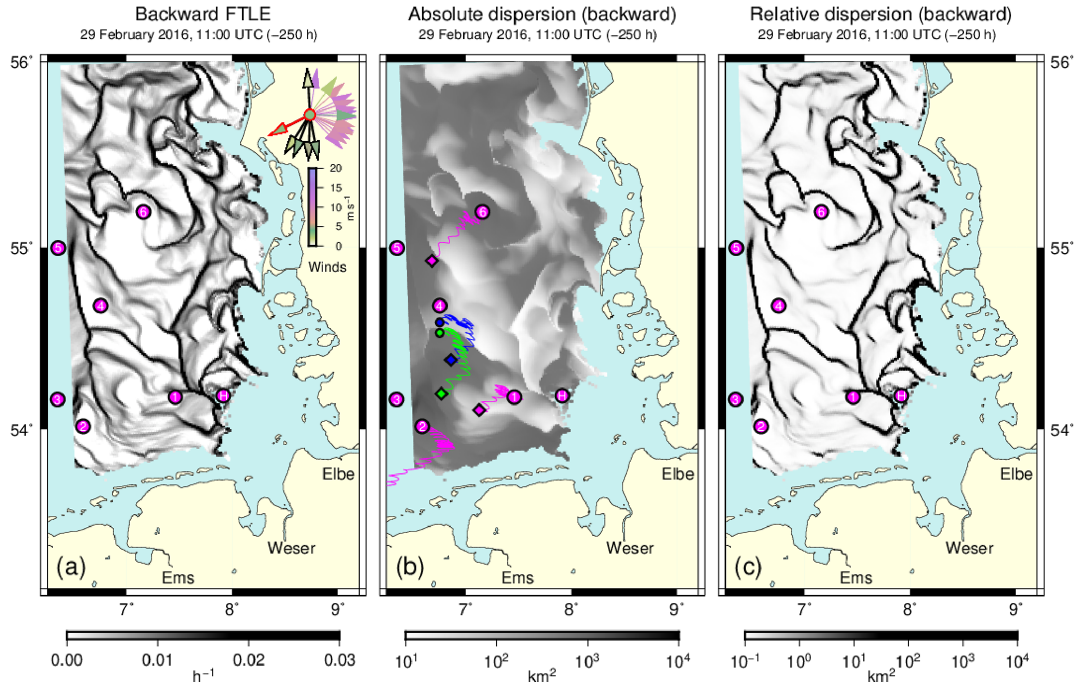
Figure 4. (a) Backward FTLE field (integration time 250h) for 29 February 2016 (11:00UTC). Magenta circles indicate the locations of the MARNET stations (1–6) and of the island of Heligoland (H). Vectors in the top-right corner show past wind directions (modelled for the location of station 4) at 10-hourly intervals. Different wind speeds are represented by a colour map. The wind vector at the time of the plot is outlined in red and those during the last 50h are outlined in black. (b) Absolute dispersion (see Eq. 12) for the same time. Example trajectories shown were initialized at MARNET monitoring stations 1, 2 and 6 (magenta) as well as at two locations (small circles in blue and green) neighbouring MARNET station 4 to its south. Small diamonds indicate each trajectory’s final location. (c) The distribution of relative dispersion (see Eq. 13) for the same